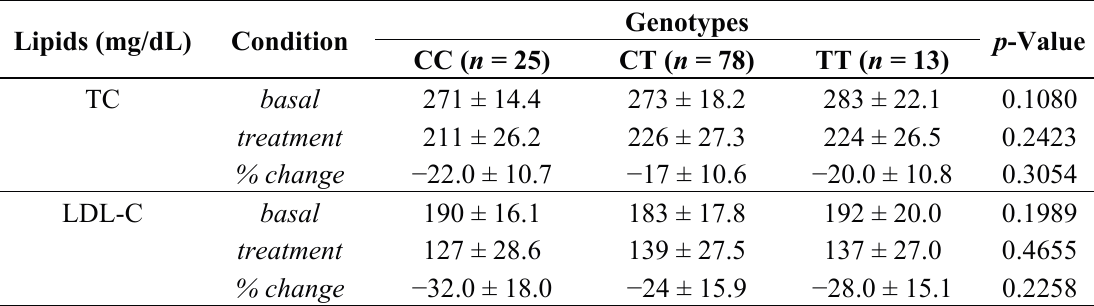
Table 3. Lipid profile and response to atorvastatin treatment (10 mg/day/4weeks) according to the low-density lipoprotein receptor ( LDLR ) rs5925 polymorphism in hypercholesterolemic Amerindian